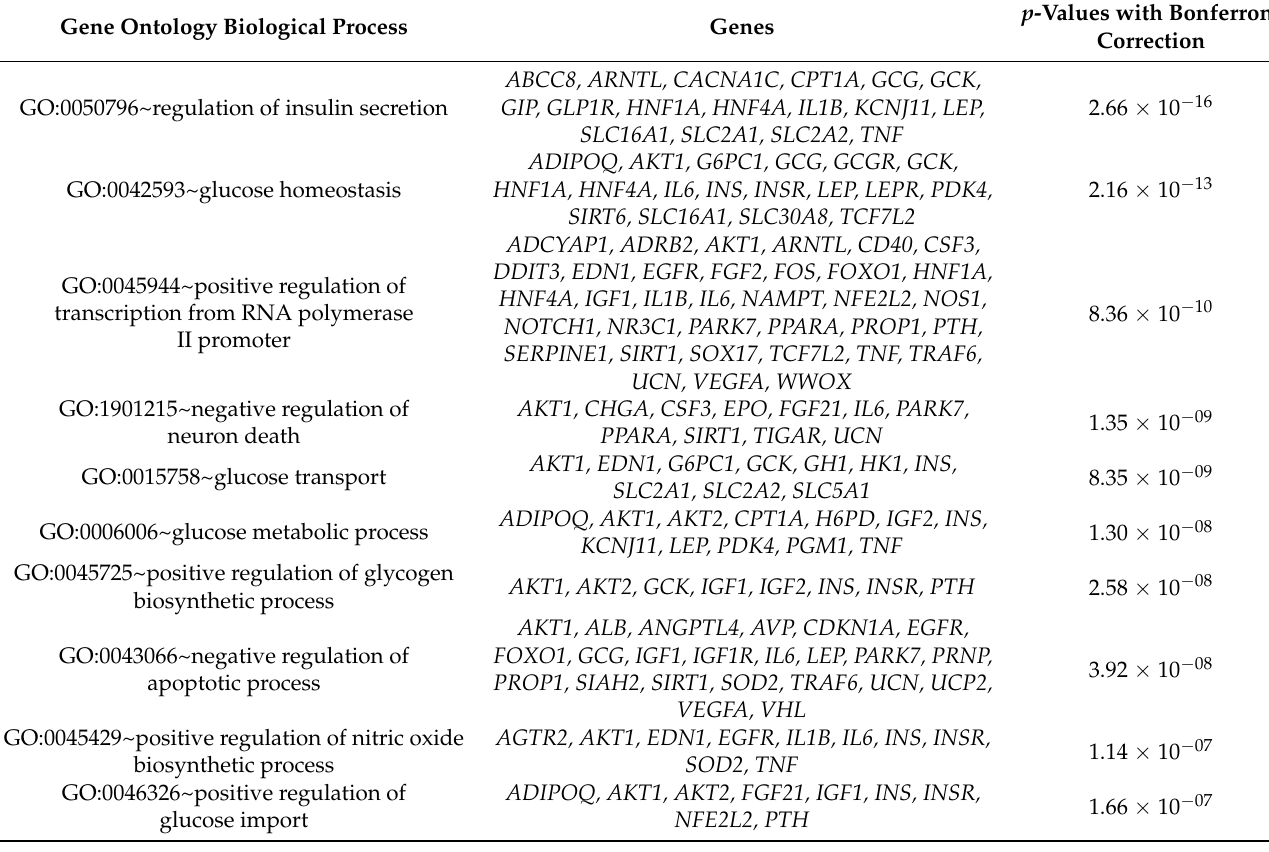
Table 3. Top 10 GO biological processes most overrepresented for hypoglycemia-related genes. Gene Ontology Biological Process Genes